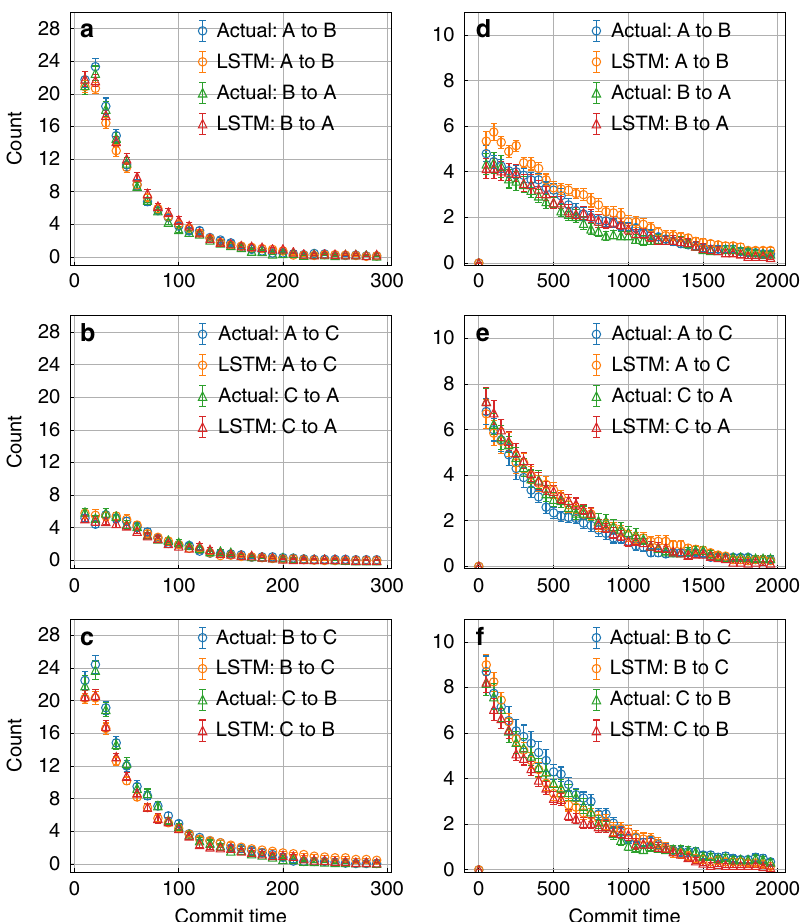
Fig. 3 Kinetics for 3-state model systems. Number of transitions between different pairs of metastable states as a function of commitment time de fi ned in “ Results ” section. The calculations for linear and triangular con fi gurations are shown in a – c and d – f , respectively. Error bars are illustrated and were calculated as standard